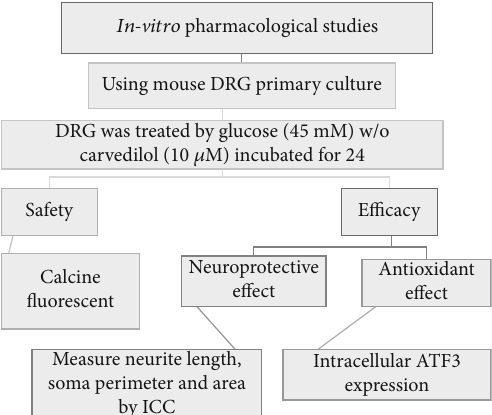
Figure 2: Procedure followed in this in vitro study.